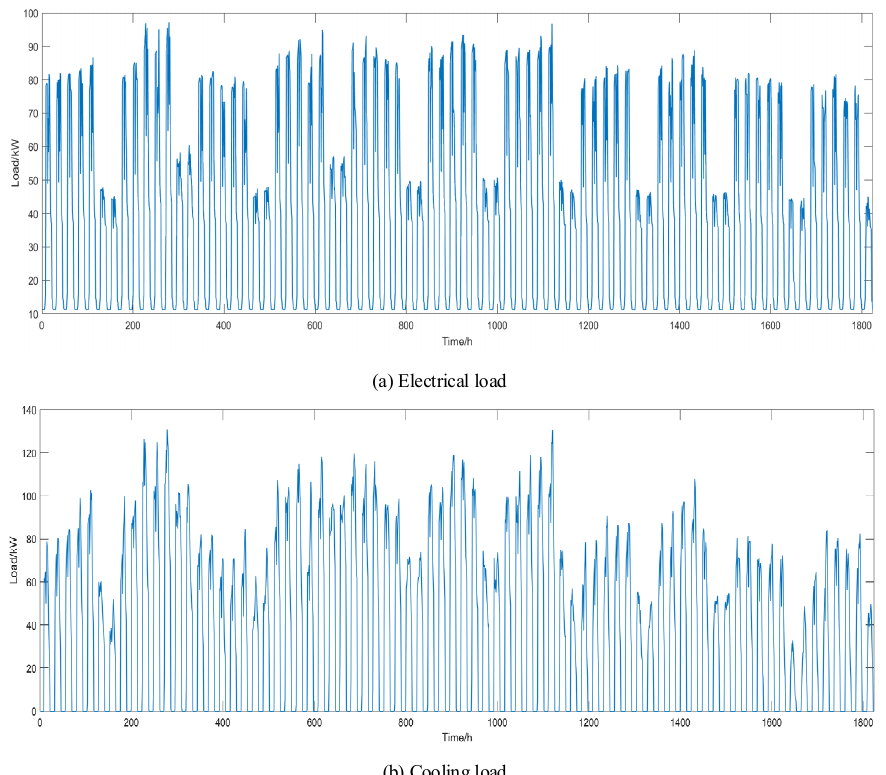
Figure 6. Load curves in summer. ( a ) Electrical load in a in a certain period of summer. ( b ) Cooling load in a in a certain period of summer.